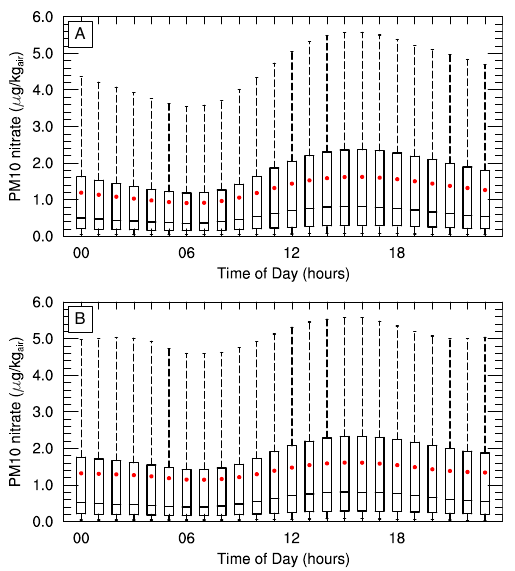
Figure 14. Statistical analysis of variation in aerosol nitrate mass loadings across the domain on the 990hPa pressure level for the “het off” and “het on” scenarios ( a and b , respectively). Hourly data from a 15-day period is used to obtain a campaign-averaged diurnal cycle (see main text for details). Whiskers indicate the 5th and 95th percentiles, while the red markers indicate mean mass